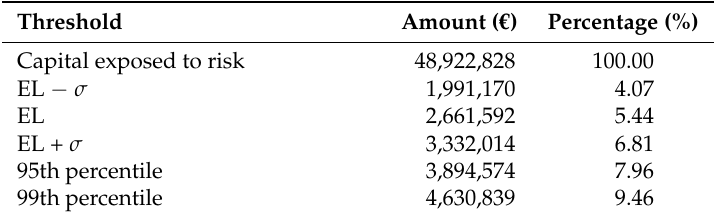
Table 11. The table illustrated the capital exposed to risk and the thresholds for loss of the portfolio with unactive loans (either repaid or defaulted) at the pool cut-off date of 2014H1. The capital exposed to risk is calculated as the sum of all the portfolio exposures net of recovery rates computed by banks and reported by ED. The total net capital is therefore 48 million euro, with an expected loss (EL) of 2.66 million. The table reports the expected loss threshold (EL ± σ ), 95th and 99th percentile